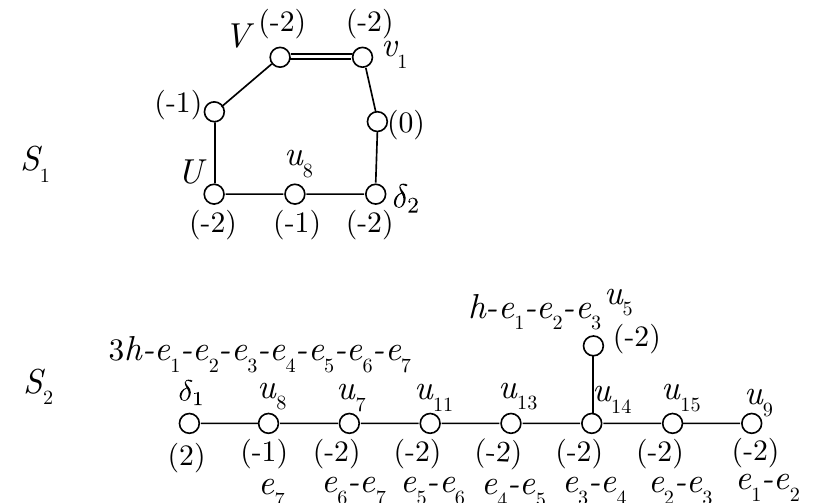
Figure 21 . The con(cid:12)guration of curves on the two non-(cid:13)at (cid:12)ber components S 1 and S 2 in the geometry D.23 before the (cid:13)op. The number in the bracket denotes the self-intersection number of the curve. The letter denotes an intersection curve with the corresponding divisor in the resolved Calabi-Yau threefold. On S 2 , we also labeled the curves with the generators of the Picard group on a rational surface (C.1). Here S 1 is not a rational